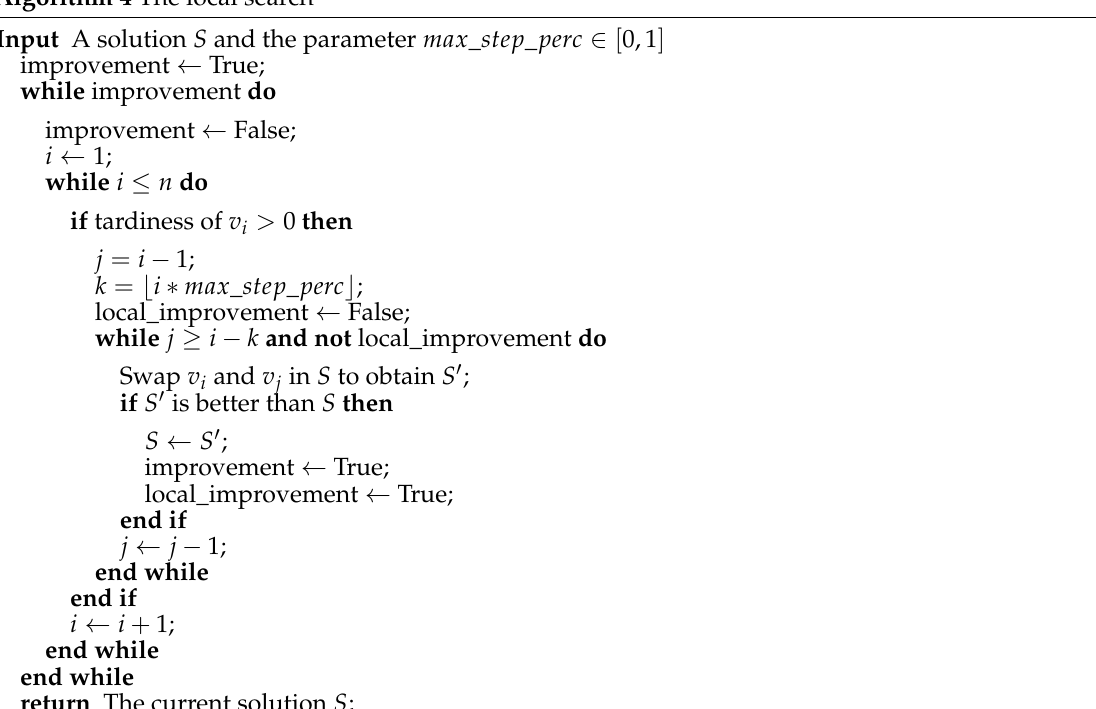
Algorithm 4 The local